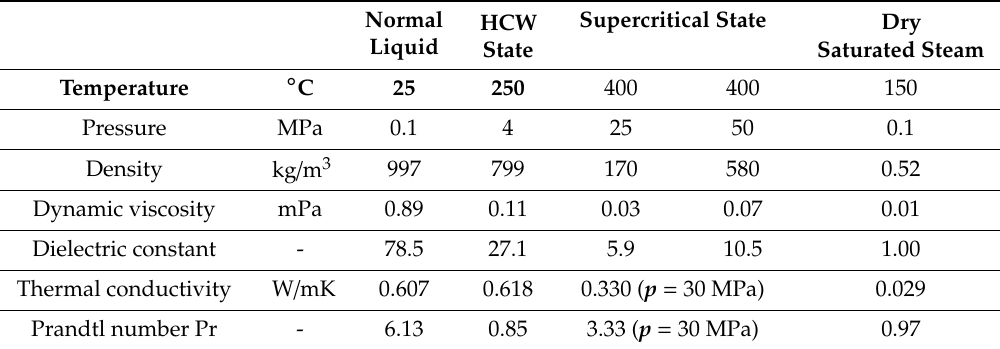
Table 6. Physical properties of water depending on its state